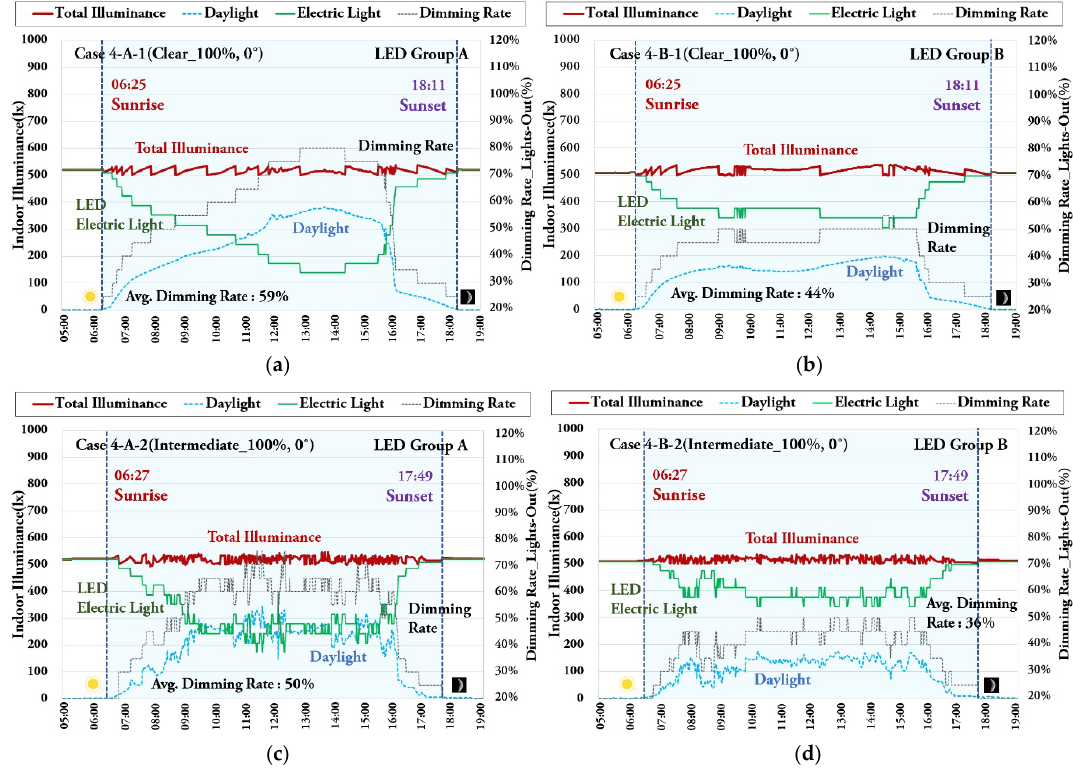
Figure 16. Illuminance and dimming rates under dimming controls integrated with manual blind control (Blind VP 100%, Slat angle 0°) (clear sky_09.24 and intermediate sky_09.28). ( a ) Case 4-A-1, ( b ) Case 4-B-1, ( c ) Case 4-A-2, and ( d ) Case 4-B-2 in Table 6.